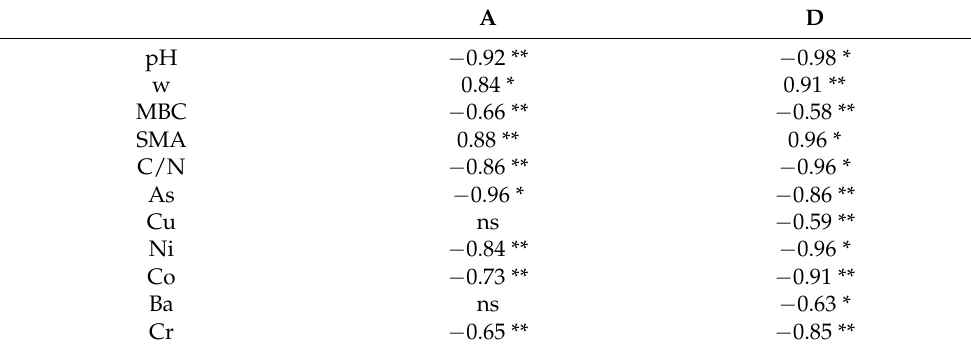
Table 4. The correlation between chemical and microbiological attributes and oribatid mites’ diversity and abundance. A, mite abundance; D, mite diversity; pH (H 2 O/KCl), negative log of the hydrogen ion concentration; w, water content in the sample; MBC, microbial biomass carbon (dry weight); SMA, soil microbial activity (respiration); C/N, total organic carbon-and-nitrogen ratio. Significance labels: * p < 0.01; ** p < 0.05; ns, non-significant. A D pH − 0.92 ** − 0.98